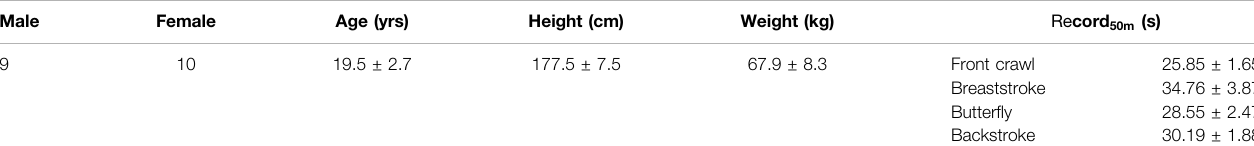
TABLE 1 | Statistics of the study participants. All variables are presented as mean ± standard deviation. Re cord 50 m is the average and standard deviation of 50 m record of the swimmers separately for each swimming technique.